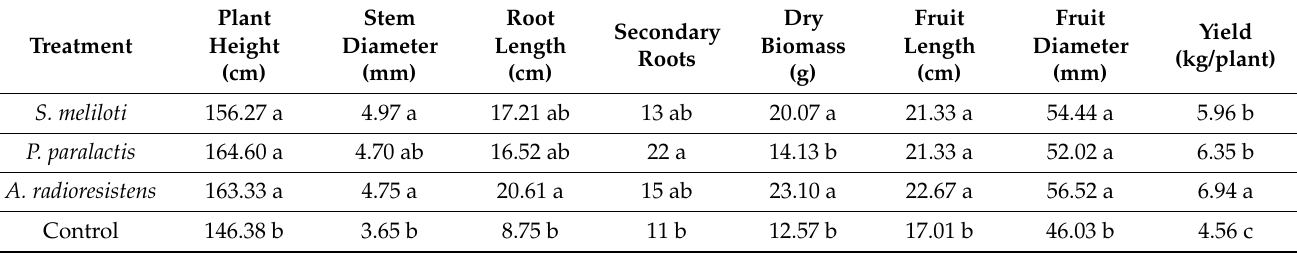
Table 1. Effect of PGPR on growth of C. sativus cultivation under greenhouse